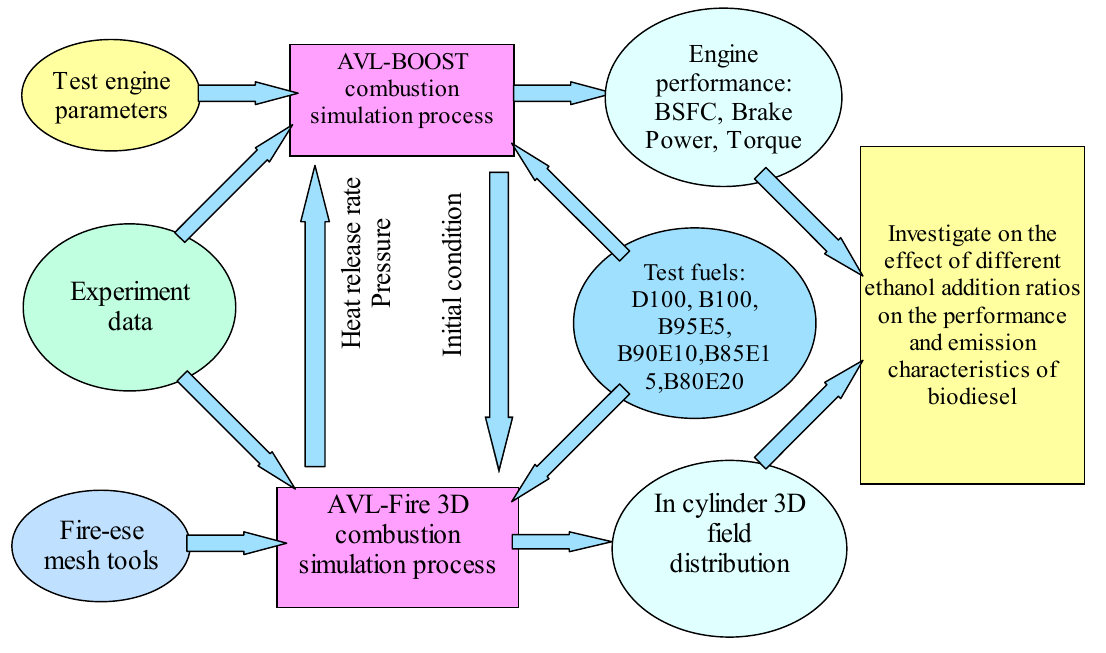
Figure 1. Coupling process of one ‐ dimensional and three ‐ dimensional calculation [1].